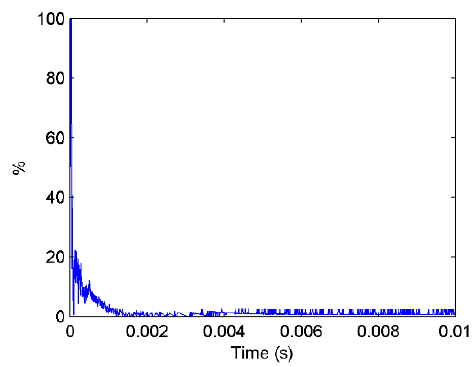
16 of 23 Figure 23. PVSE output absolute error.